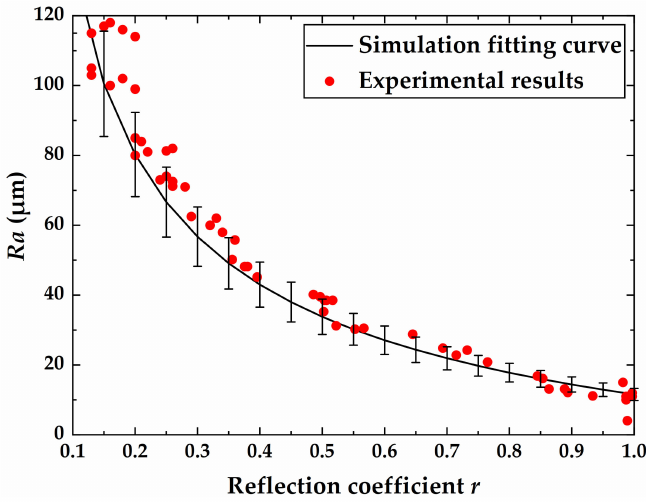
Figure 15. Experimental results for ice surface roughness in the range of [0, 120] µ